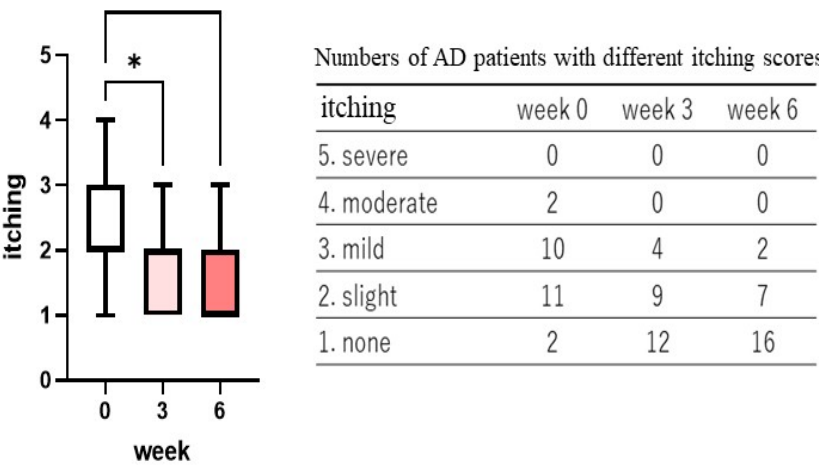
Figure 5. Clinical effects of the POLG nano-emulsion on stimulus sensations of the skin of AD pa- tients. Stimulus sensations were assessed by a dermatologist (KN) after querying each subject at 0, 3, and 6 weeks, and were scored on a 1–5 grading basis (1 = none; 2 = slight; 3 = mild, 4 = moderate; 5 = severe). n = 25; ***: p < 0.001, ****: p < 0.0001 compared to week 0; all data were analyzed using Dunn’s multiple comparisons test.